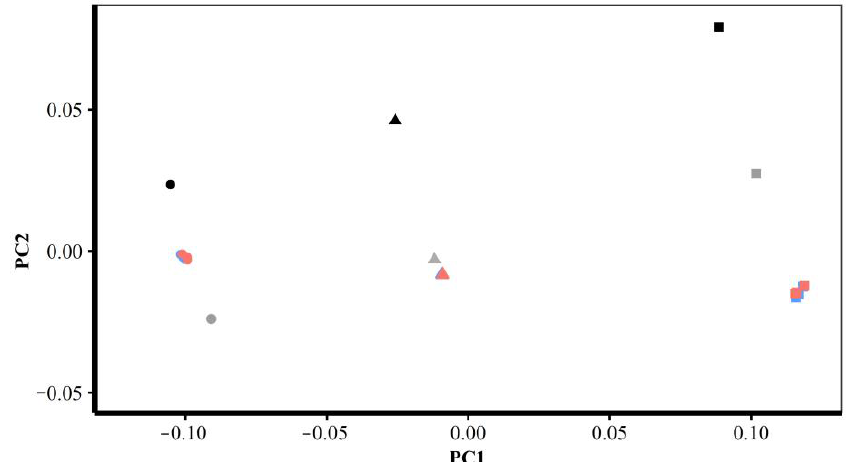
Figure 28. PC1 (93.2% of total variance) vs. PC2 (6.04%) from PCA of the mean and allometrically scaled ape cranial surfaces derived using varying semilandmark densities and each semilandmarking approach (from Figure 18). Red = sliding TPS; blue = TPS&NICP. Also included in this PCA are surfaces warped to the mean and scaled landmark configurations; the ape cranial surface used to generate the template (black); and the template surface (grey). Triangles = means, squares = allometric predictions of surfaces at the sample minimum centroid size, circles = allometric predictions of surfaces at the sample maximum centroid size.